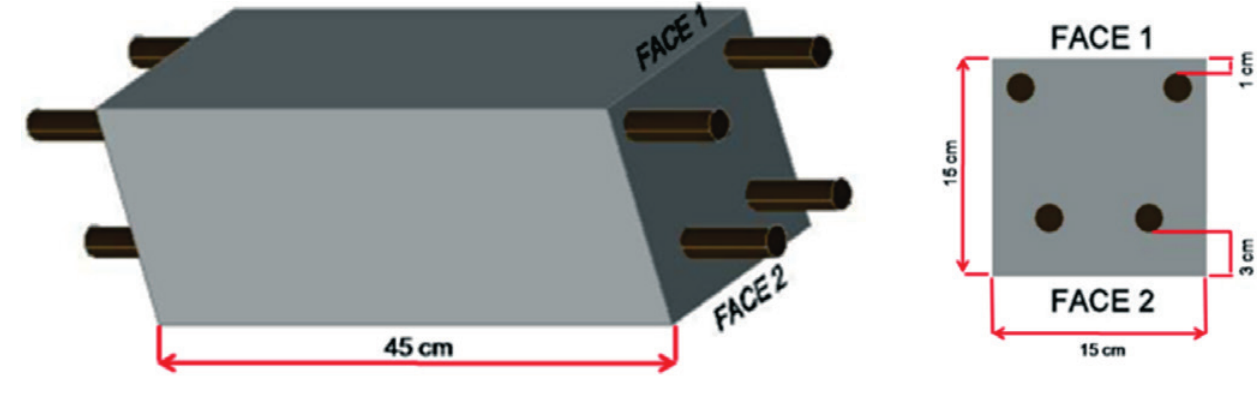
Schematic representation of prismatic test